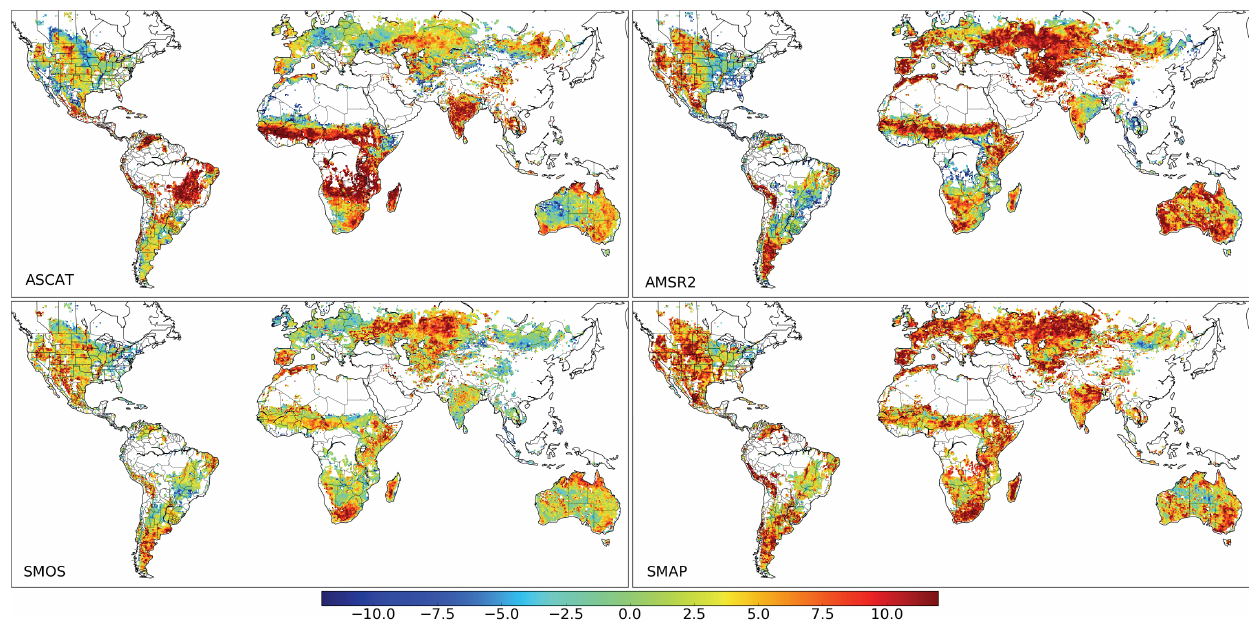
Figure 5. Signal-to-noise ratio (in dB), estimated with the triple collocation analysis for four different satellite-based soil moisture products and a land surface model. (a) MetOp-A ASCAT based on the TU Wien method (Wagner et al., 1999); (b) AMSR2 based on the LPRM model (Owe et al., 2008); (c) SMOS L3 (Kerr et al., 2010); (d) SMAP (Jackson, 1993). An SNR of − 3 indicates a signal variance that is half of the noise variance, an SNR of 0 a signal variance equal to the noise variance, an SNR of 3 a signal variance that is twice the noise variance and so on. In areas without data the TC could not be computed, e.g. because of too few observations in one of the data sets. For details see Gruber et al.